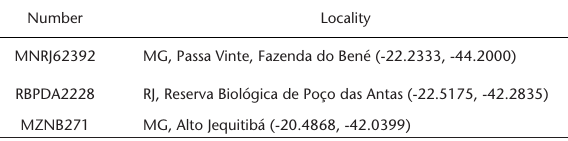
Table 3. Phyllomys lundi specimens in mammal collections, with catalog number, and collecting localities. MN = Museu